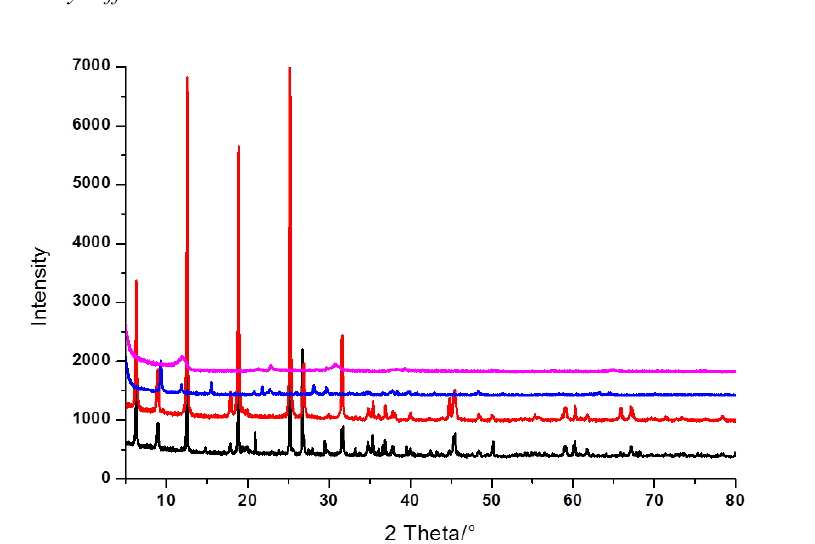
Fig. 1. XRD pattern of the four clays, ROC, POC, COC and